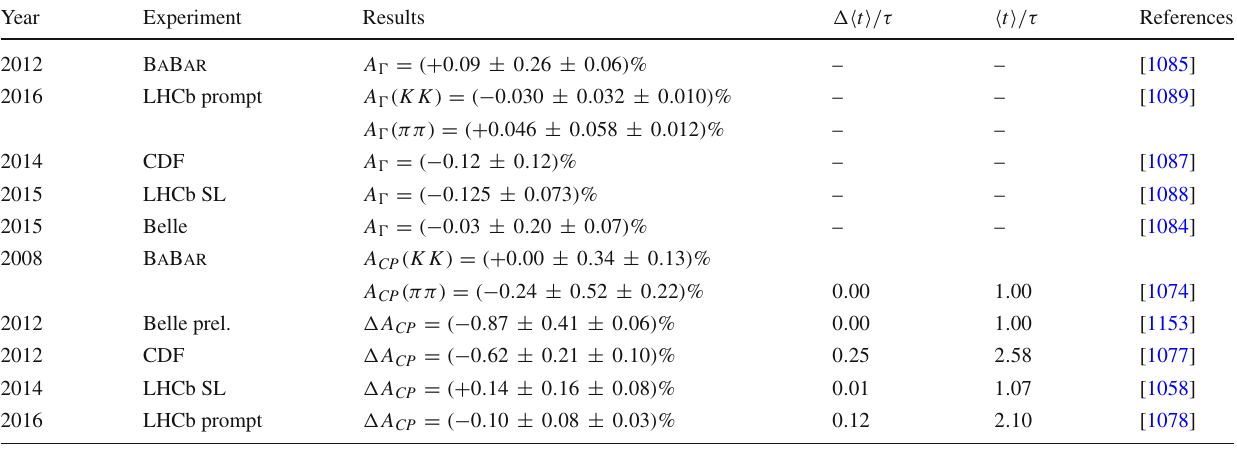
Table 270 Inputs to the fit for direct and indirect CP violation. The first uncertainty listed is statistical, and the second is